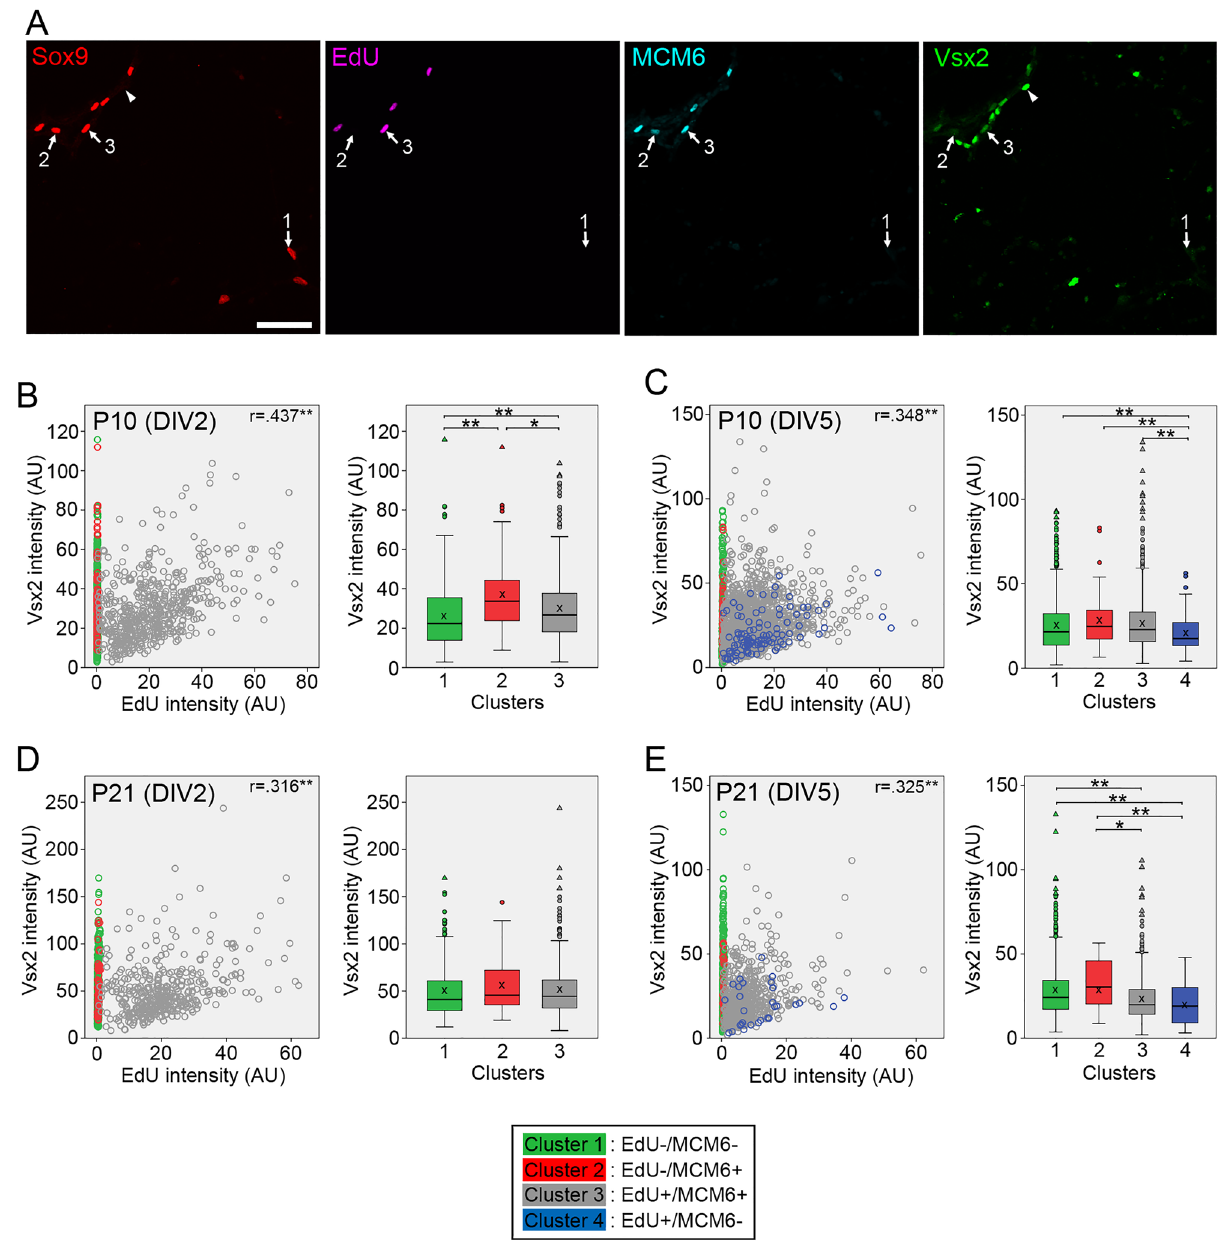
Figure 5. Quantitative analyses of Vsx2 expression in Müller glia dissociated from P10 and P21 mouse retinas. Intensities of EdU, MCM6 and Vsx2 labeling in Sox9 + Müller glia are quantitated by image analysis. Vsx2 levels in Müller glia classified into four clusters are shown as scatter plots and box plots. ( A ) Confocal images of quadruple labeling for Sox9, EdU, MCM6 and Vsx2 in Müller glia from P10 retina at DIV2. The numbers represent the clusters. Arrowheads denote Vsx2+/Sox9− bipolar cells. Scale bar = 50 µm. ( B ) Plots of 1061 Müller glia from P10 retina at DIV2. ( C ) Plots of 2305 Müller glia from P10 retina at DIV5. ( D ) Plots of 916 Müller glia from P21 retina at DIV2. E. Plots of 1354 Müller glia from P21 retina at DIV5. AU arbitrary units. r , Spearman’s correlation coefficients between Vsx2 and EdU intensities in the cluster 3. X in box plots indicates the mean. * P < 0.05, ** P <